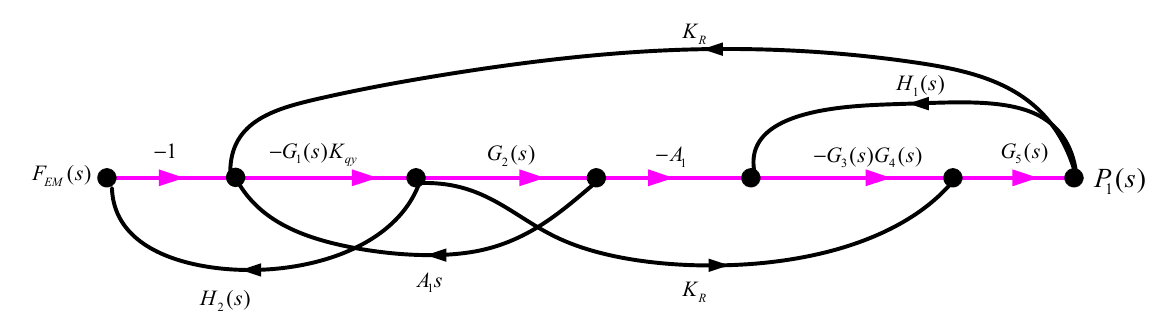
Figure 9. Signal flow diagram of the traditional proportional relief valve control system.